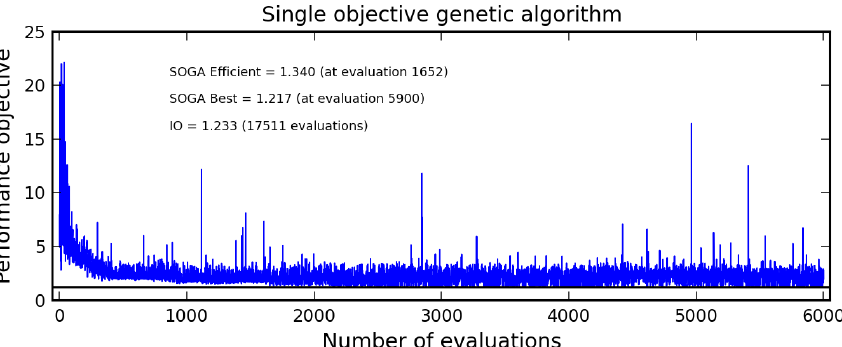
Figure 4. The figure displays the raw objective function evaluations during the evolution of a population of network designs using SOGA to optimize performance. The horizontal black line shows the SOGA Best case. The SOGA Best, SOGA Efficient, and IO cases are also